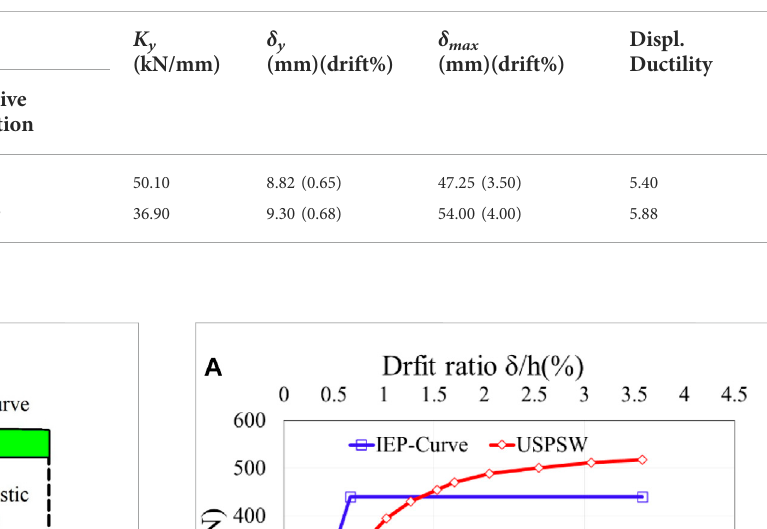
TABLE 4 Summary of the test results.